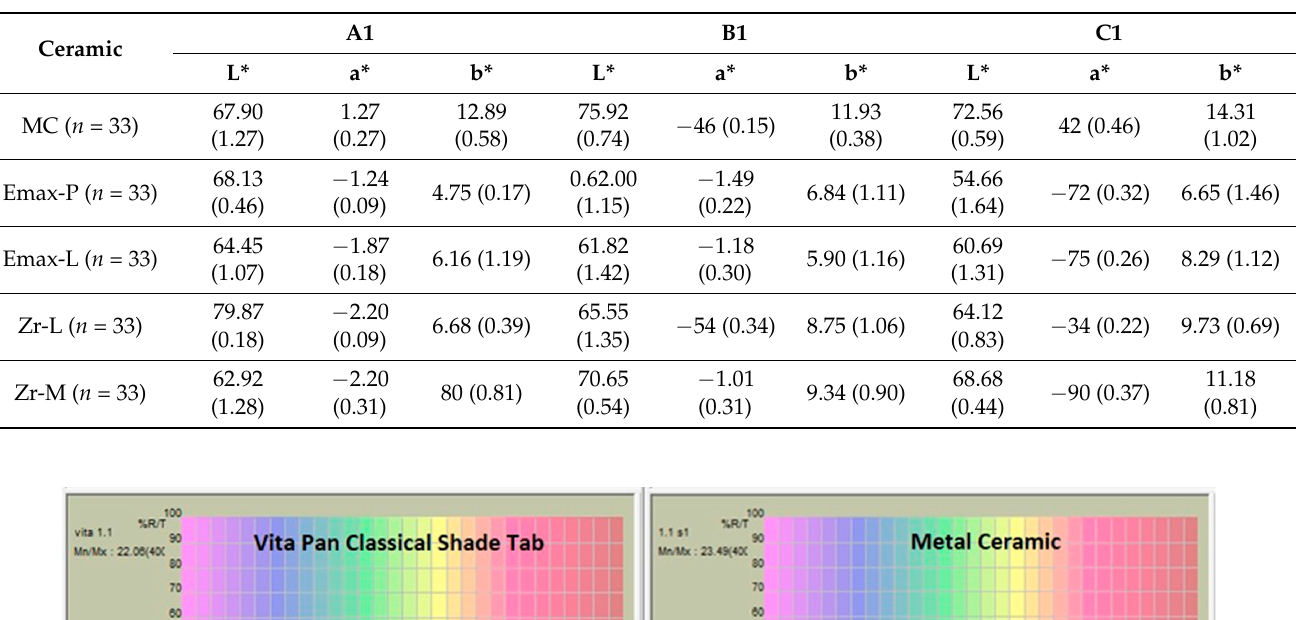
Table 2. Descriptive statistics of the mean (standard deviation) of L* a* b* values recorded with a spectrophotometer for the five tested materials ( N = 165).